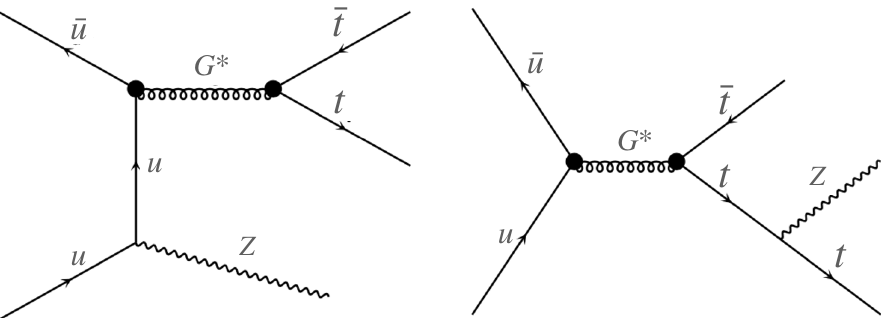
Figure 9 . A representative subset of Feynman diagrams of the process pp → t ¯ tZ mediated by a KK gluon. These are only two of the 16 diagrams containing a KK gluon out of a total of 116 involved in the process.